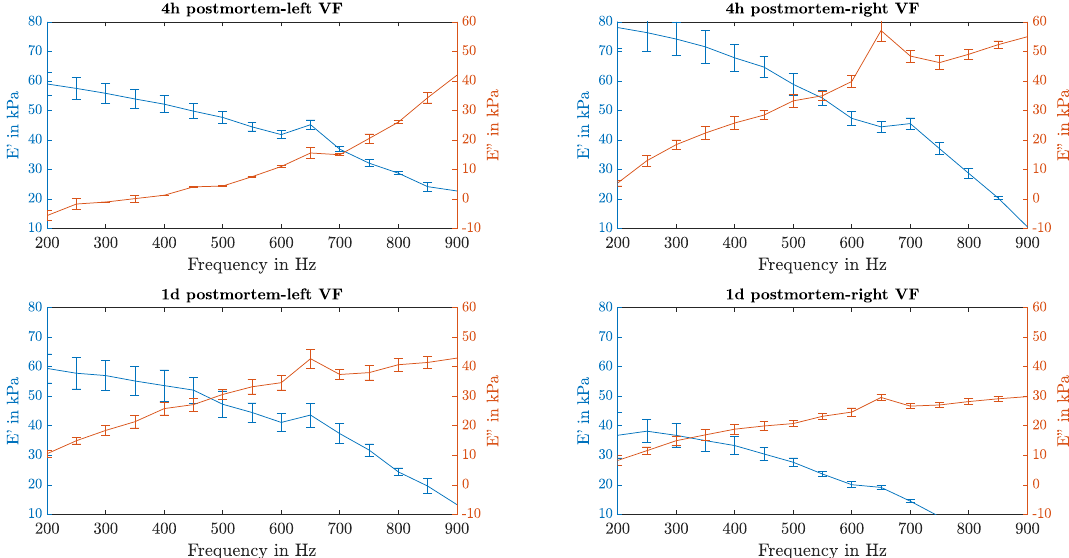
Figure 17. Complex elasticity of the sample K6: Measurements 4h and 1d postmortem (upper and lower row) for each VF side are plotted separately (left and right column). The storage modulus E (cid:48) is given on the left Y-axis (blue) and the loss modulus E (cid:48)(cid:48) on the right